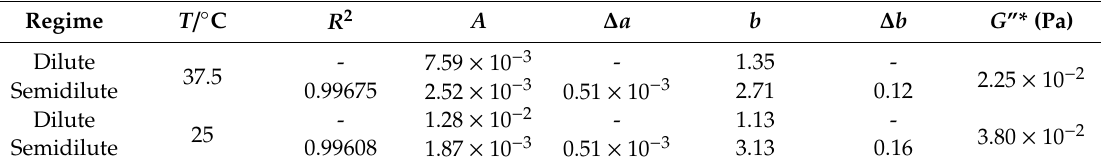
Table 2. Values of coe ffi cients a and b of equation G (cid:48)(cid:48) = a · c b related to the fitting of the Frequency Sweep data.